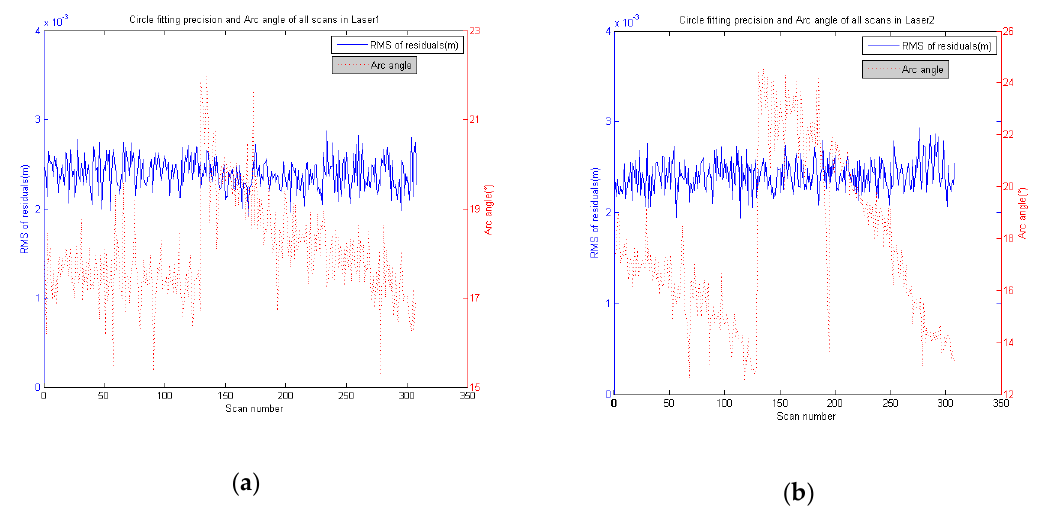
Figure 8. ( a ) The circle fitting accuracy and arc angle for all scans of Laser1. ( b ) The circle fitting accuracy for all scans of